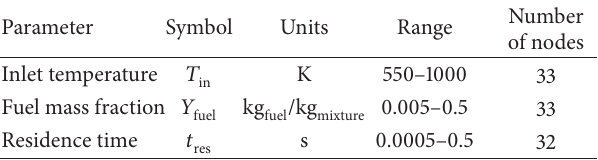
Table 1: Variation range of selected independent parameters. Parameter